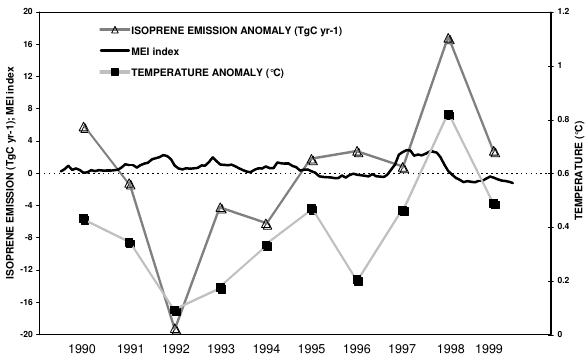
Fig. 11. Inter-annual variability of simulated global total isoprene emissions anomalies, global average land air temperature anomalies from the historical surface temperature dataset CRUTEM3 (Brohan et al., 2006) and Multivariate El Ni˜no/Southern Oscillation (ENSO) Index (MEI; Wolter and Timlin, 1993, 1998) over the